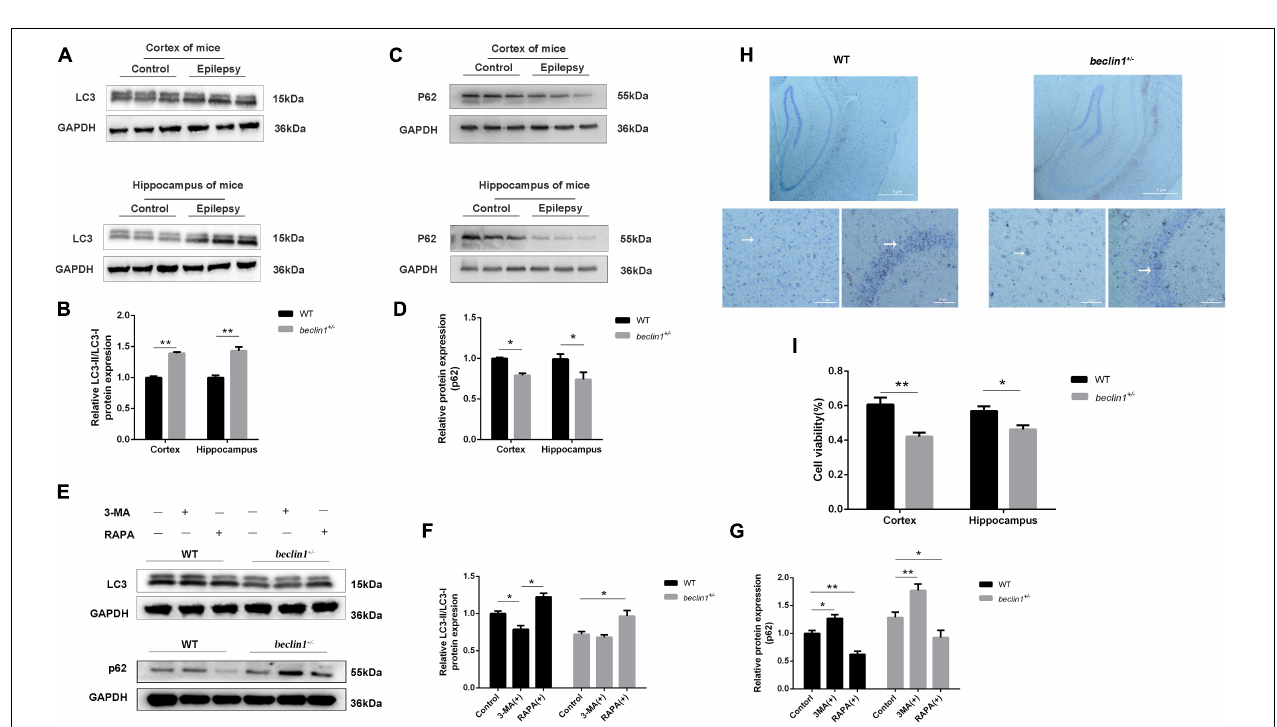
FIGURE 2 | Autophagy was activated in epilepsy but suppressed in beclin1 ± mice. (A,B) LC3-II/LC3-I protein levels in the cortex and hippocampus of brain tissues from wild-type (WT) and epilepsy model mice ( n = 3 mice per group). (C,D) p62 protein levels in the cortex and hippocampus of brain tissues from WT and epilepsy model mice ( n = 3 mice per group). (E,G) LC3-II/LC3-I and p62 protein level in cultured primary neurons from WT and beclin1 ± mice under basal conditions and upon autophagy induction (RAPA)/blockade (3-MA) ( n = 3 samples per group). (H) Nissl staining of WT and beclin1 ± mouse brain slices. Scale bars: 52 µ m. (I) The viability of cultured neurons dissected from WT and beclin1 ± mice was detected using the MTT assay ( n = 6 samples per group). Data are presented as the means ± SEM. * p < 0.05 and ** p < 0.01. Student’s t -tests and one-way ANOVA were performed.